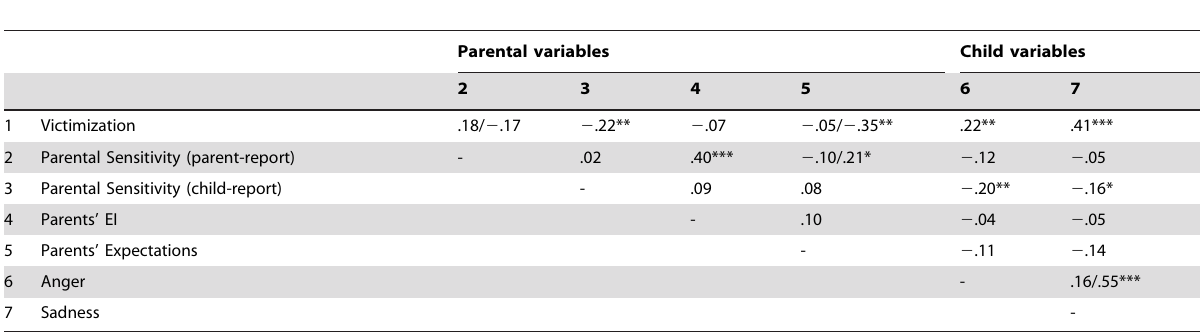
Table 5. Spearman Correlations between Victimization, Parental- and Child